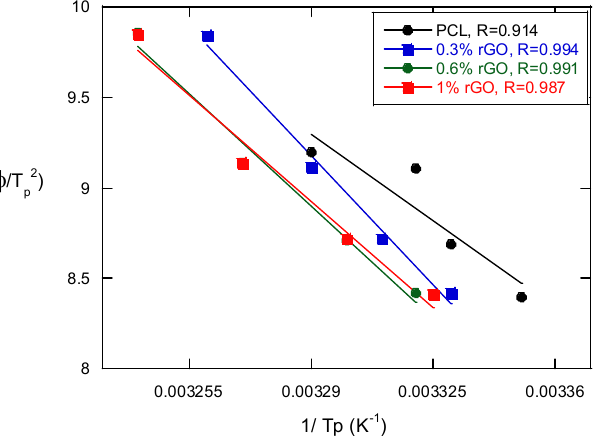
Figure 6. The Kissinger plots of PCL and its composite scaffolds with rGO for the estimation of crystallization activation energy in non ‐ isothermal melt crystallization.